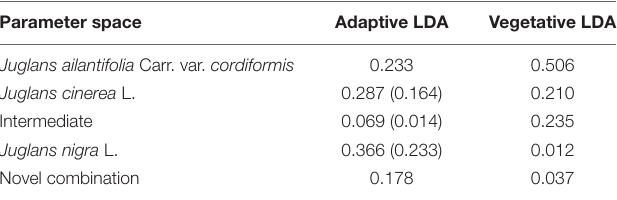
TABLE 4 | Proportion of J. × bixbyi Rehd. individuals assigned to the parameter space of Juglans ailantifolia Carr. var. cordiformis , J.